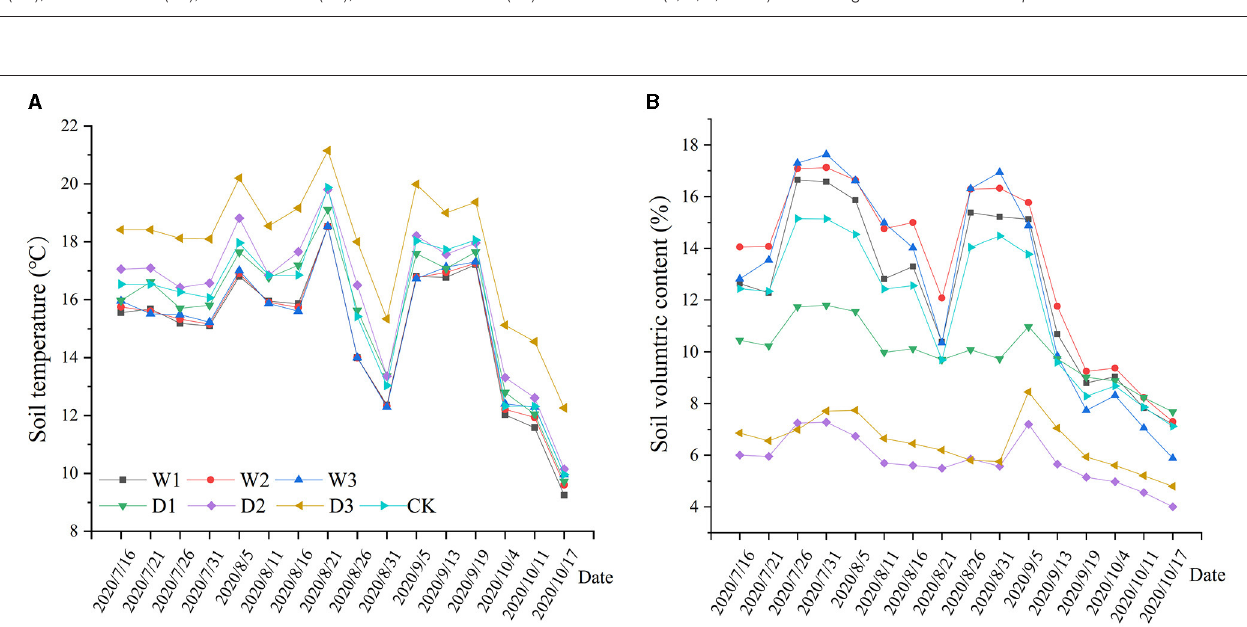
FIGURE 5 | Daily mean (A) soil temperature (ST) and (B) moisture in each precipitation treatment; 25% increase (W1), 50% increase (W2), 75% increase (W3), control (CK), 25% reduction (D1), 50% reduction (D2), and 75% reduction (D3).